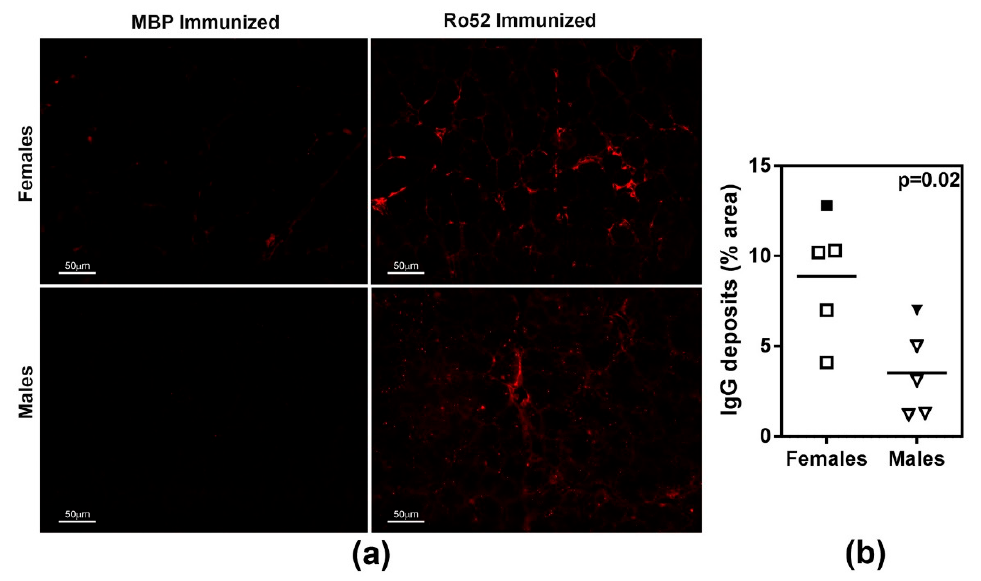
Figure 4. IgG deposits in lacrimal glands of female and male mice immunized with Ro52 and MBP. ( a ) The presence of IgG deposits in lacrimal glands was evaluated by direct immunofluorescence by